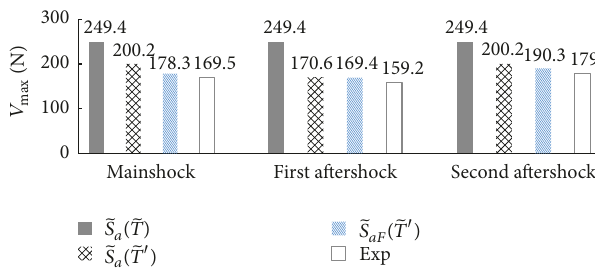
Figure 17: Calculation of the maximum base